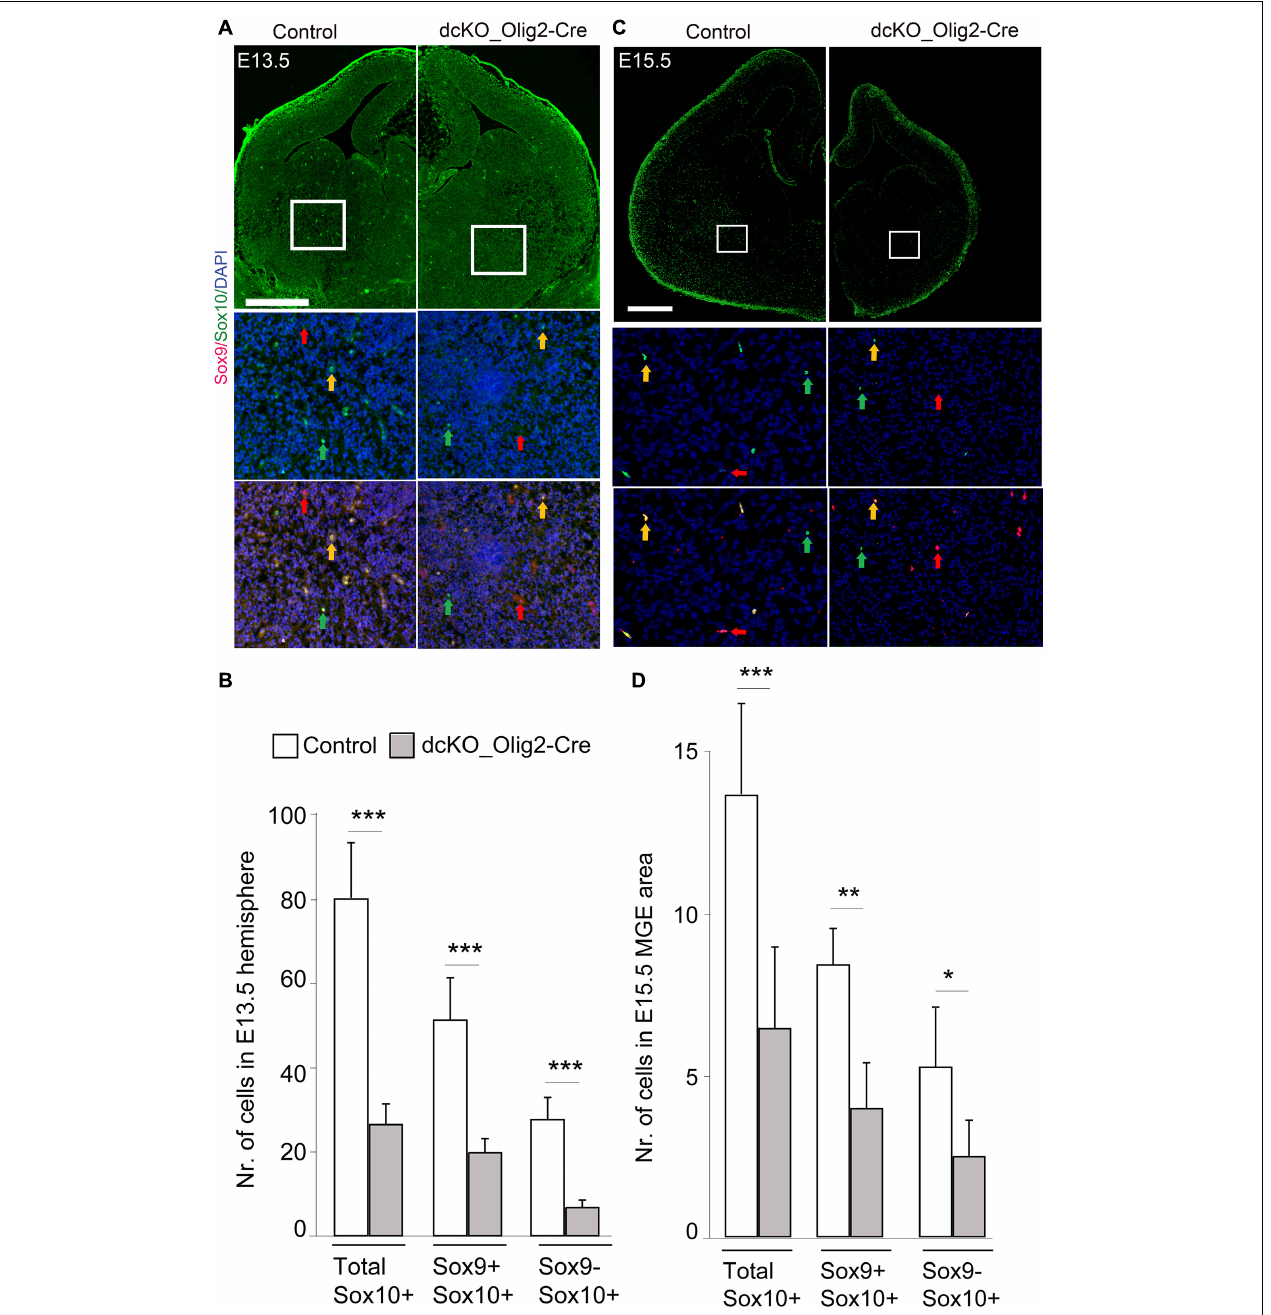
FIGURE 4 | Specification of oligodendrocyte precursors is impaired in the dcKO_Olig2-Cre. (A,C) Immunomicrographs showing Sox9 and Sox10 in the E13.5 (A) E15.5 (C) control and dcKO_Olig2-Cre forebrain. Selected regions of the striatum are shown at higher magnification. Yellow arrows point to cells co-expressing Sox9 and Sox10. Green arrows point to cells expression only Sox10. Red arrows point to cells expressing only Sox9. DAPI counter staining is shown. (B,D) Bar plots showing statistical difference in the number of cells (co)expressing Sox9, Sox10, or Sox9/Sox10 in the E13.5 (B) E15.5 (D) control and dcKO_Olig2-Cre forebrain. Data are shown as means ± SEMs. Experimental replicates ( n ) = 6; * p ≤ 0.01, ** p ≤ 0.001, *** p ≤ 0.0001. Scale bars = 100 µ